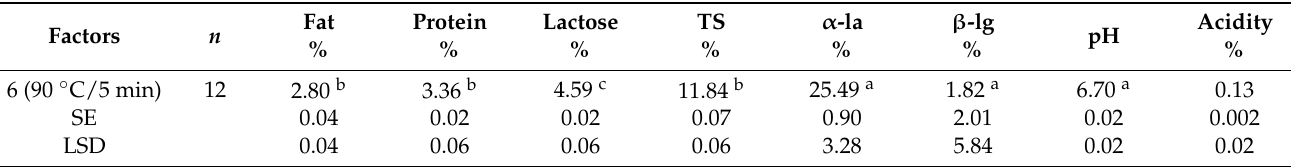
Table 2. Means of compositional parameters of Quark-type cheeses made from unhomogenized and homogenized full- and reduced-fat milk heated under different conditions.